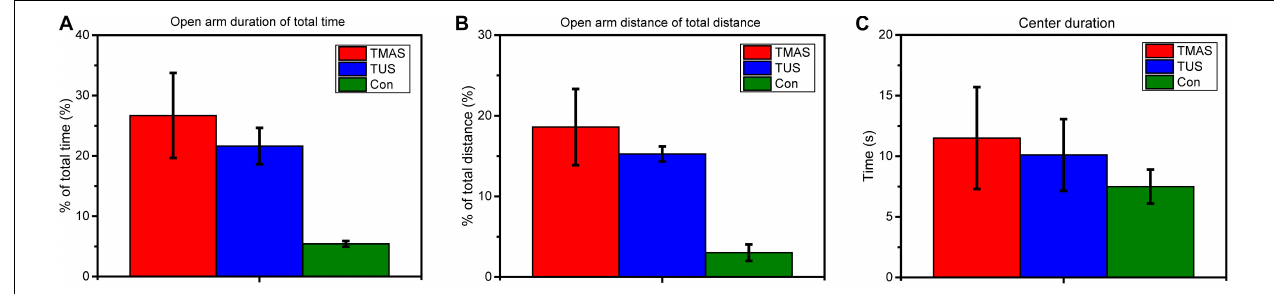
FIGURE 9 | Elevated plus-maze test and open field behavior test results from stimulation experiments in healthy mice ( n = 3). (A) The open arm duration (the time that mouse spent in the open arms during the test) of total time (%) and (B) the open arm distance (the distance that mouse traveled in the open arms during test) of total distance (%) in the elevated plus-maze test. (C) The center duration time (the time that mouse spent in the center area) in the open field behavior test.